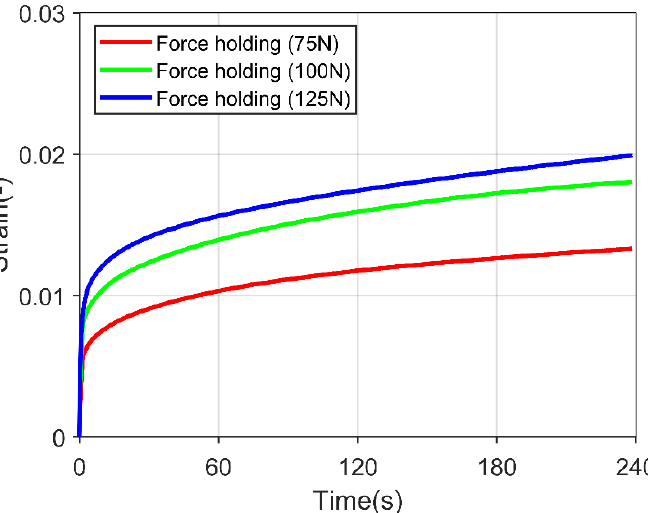
Figure 3. Polycrystalline ice specimen subjected to constant force load for 240 s under three different forces.